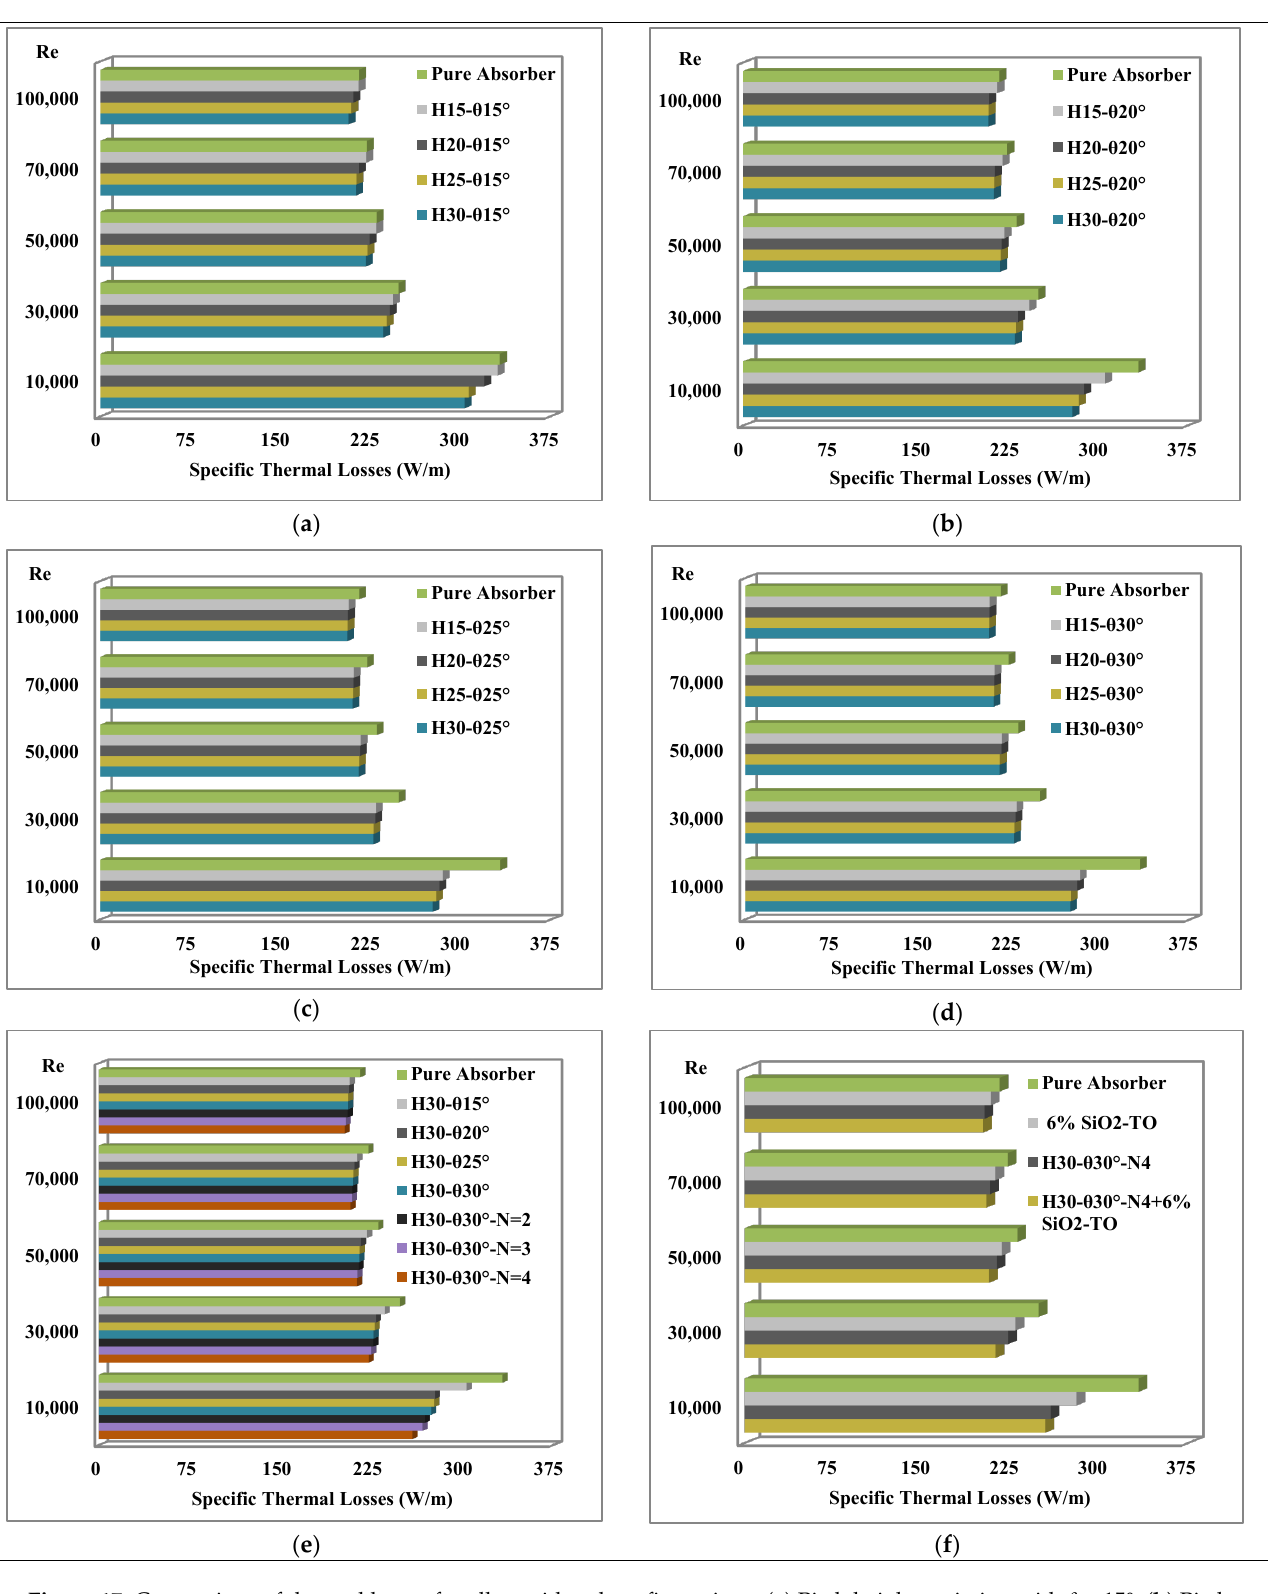
Figure 17. Comparison of thermal losses for all considered configurations. ( a ) Pitch height variation with θ = 15°, ( b ) Pitch height variation with θ = 20°, ( c ) Pitch height variation with θ = 25°, ( d ) Pitch height variation with θ = 30°, ( e ) Pitch angle ( θ ) and number of inserts (N) variation with fixed pitch height, ( f ) Optimal configuration with and without nanofluids.